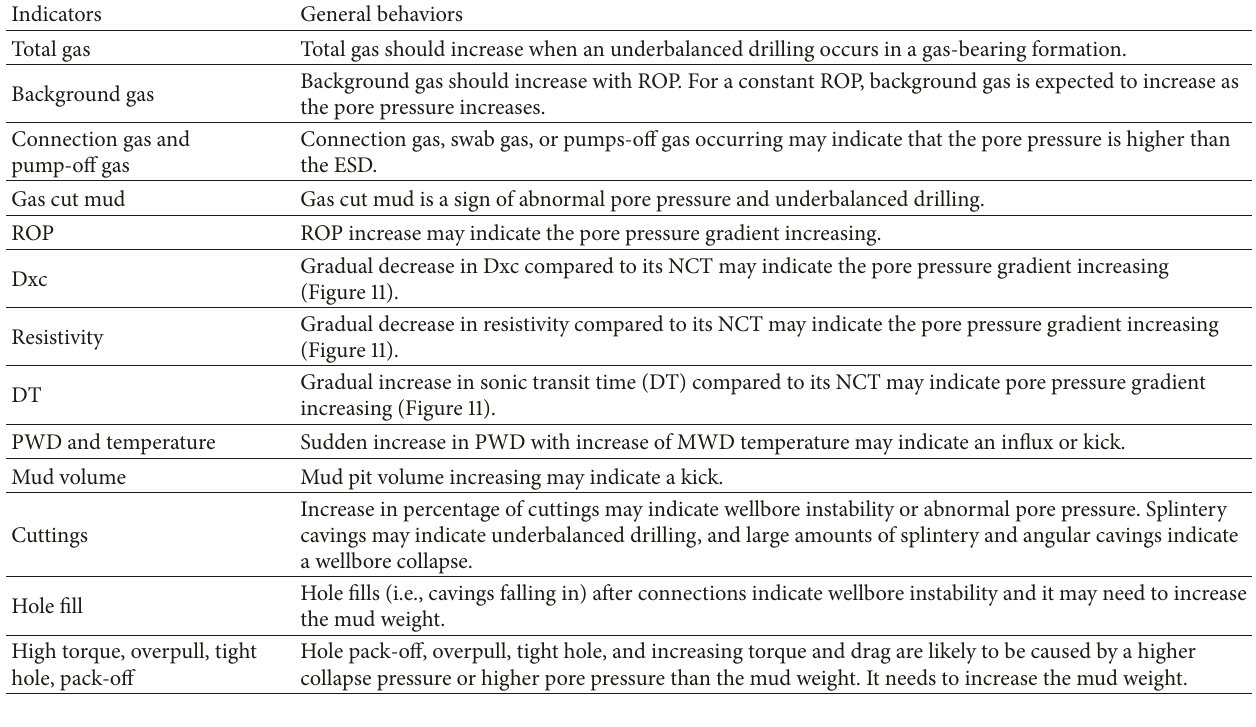
Table 1: Real-time indicators of abnormal pore pressures.